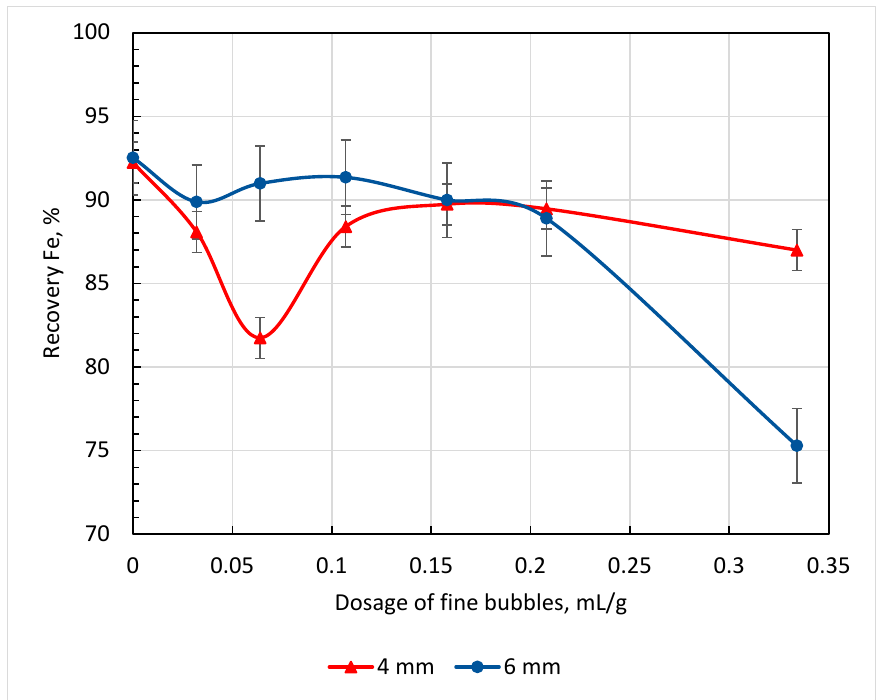
Figure 13. Dependence of iron recovery on fine bubble dosage upon treatment in TFRs having 4 and 6 mm inner diameters. CTAB dosage—20 g/t, treatment time—7.5 s. (Error bars represent the standard deviation obtained from 3 test repeats).